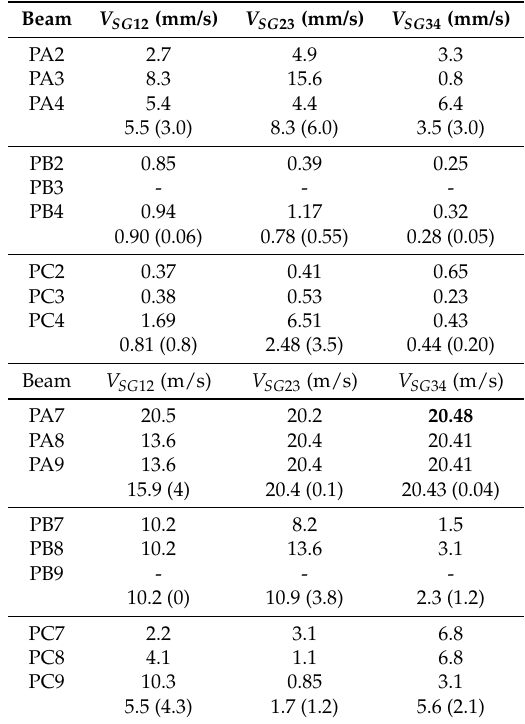
Table 6. Measured crack speed for the quasi-static loading rate of 2.2 µ m/s (specimens PX2, PX3 and PX4) and 22 mm/s (specimens PX7, PX8 and PX9), the corresponding mean and standard deviations are given in the fourth row of each concrete type.